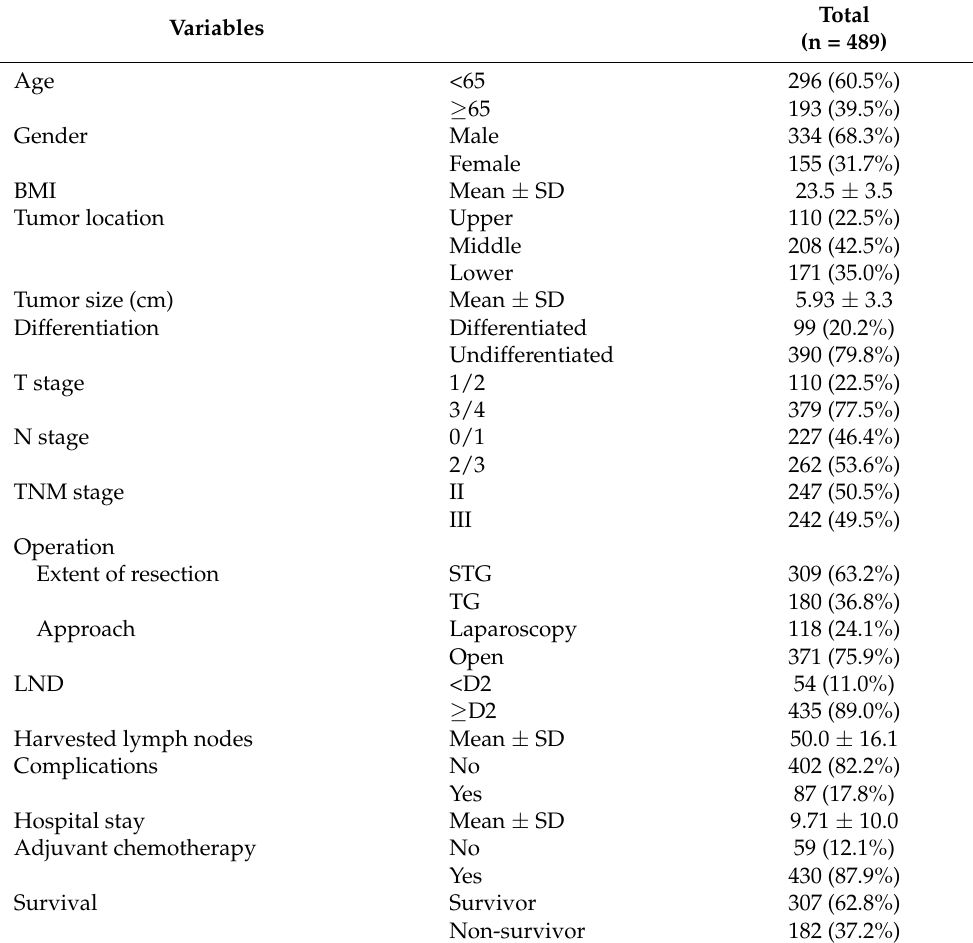
Table 1. Baseline characteristics of included